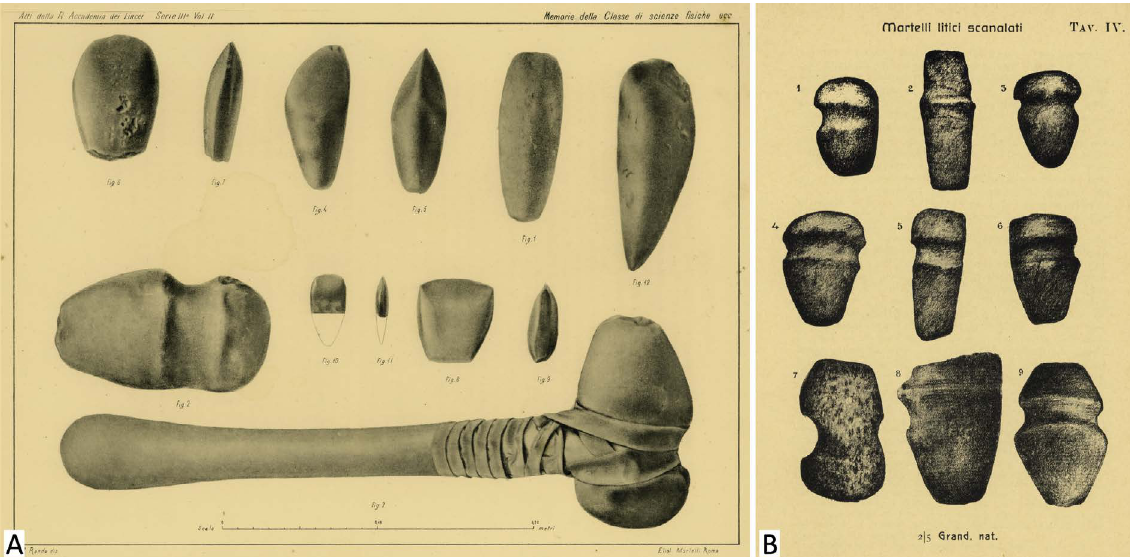
Figure 1. A. Drawings of polished stone industry from Calabria, including a grooved tool with and without the wooden handle (Lovisato 1878b). B. Graphical representation of nine “grooved stone hammers” found in Calabria (Topa